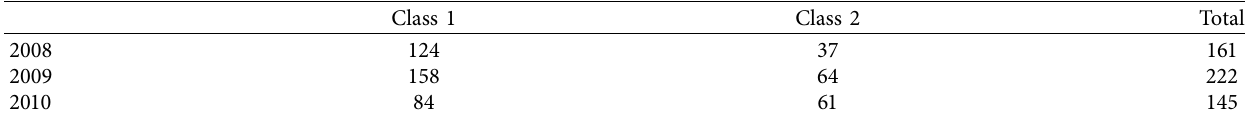
Figure 5: Fitting curve of model hidden layer design. Table 4: 2008-2009 statistical table of Class 1 and Class 2